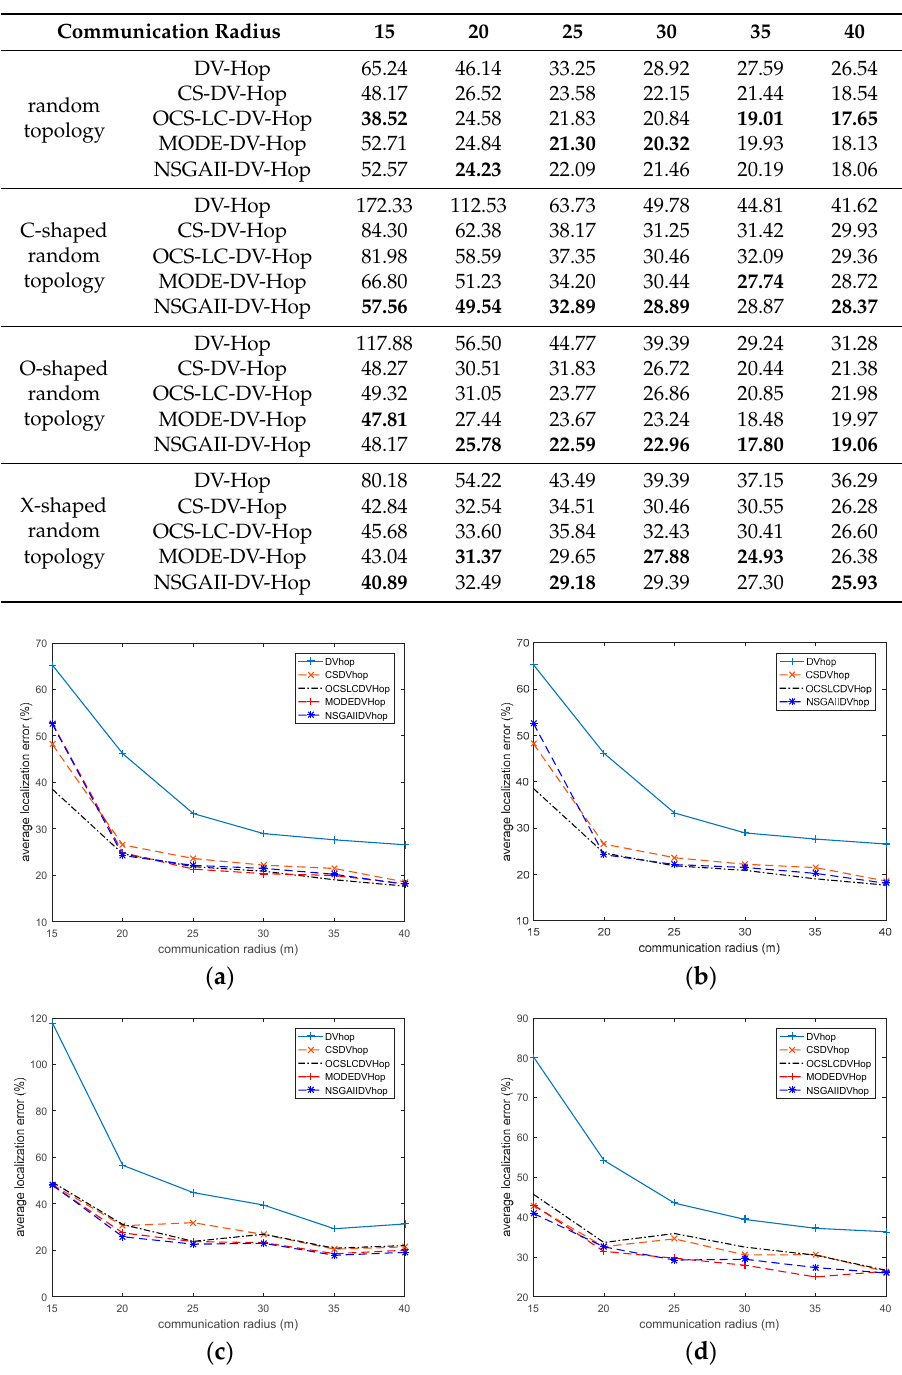
Table 2. Average localization error (ALE) of different algorithms in different network topologies and communication radius.